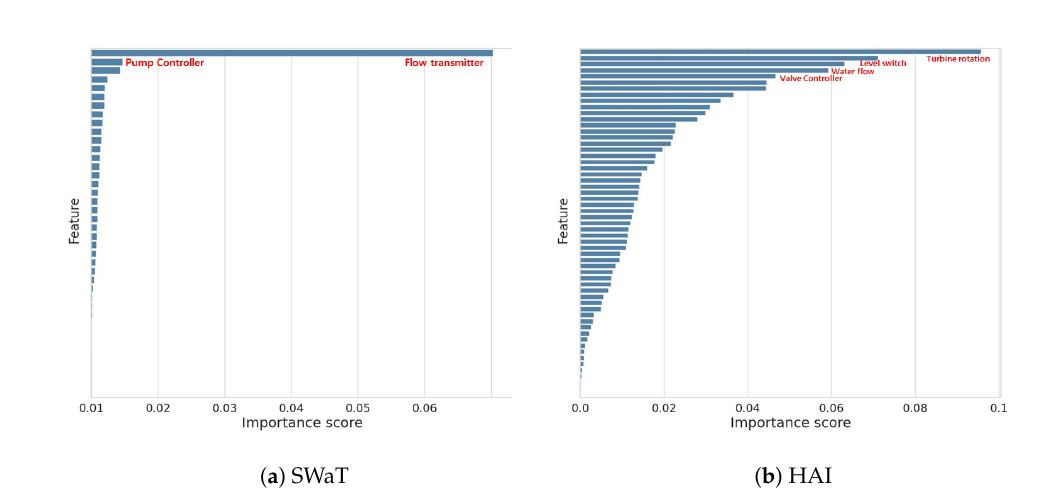
Figure 3. Feature importance score plots based on the SWaT and HAI datasets.